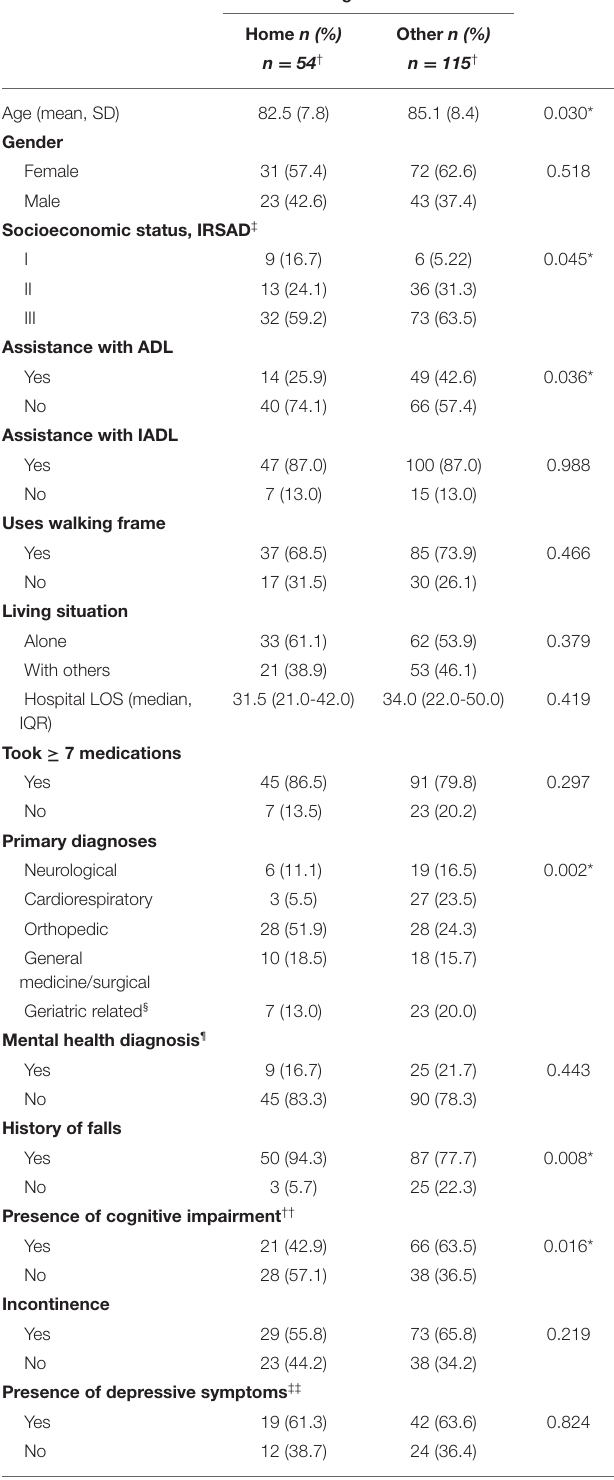
TABLE 1 | Older adults’ characteristics—group comparisons for cases discharged home compared to other discharge destination. Cases